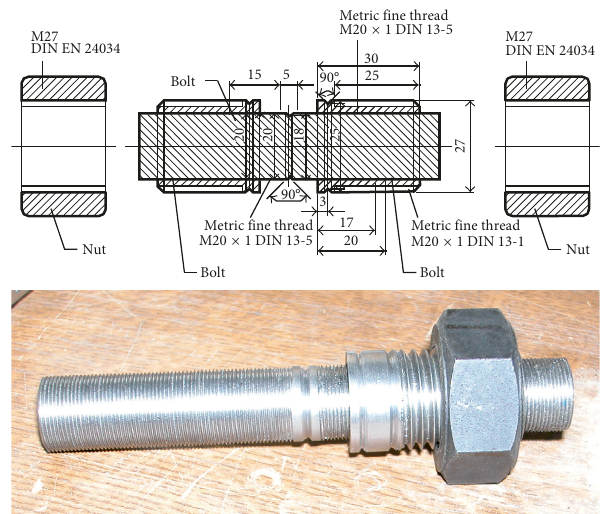
Figure 5: Adjustable